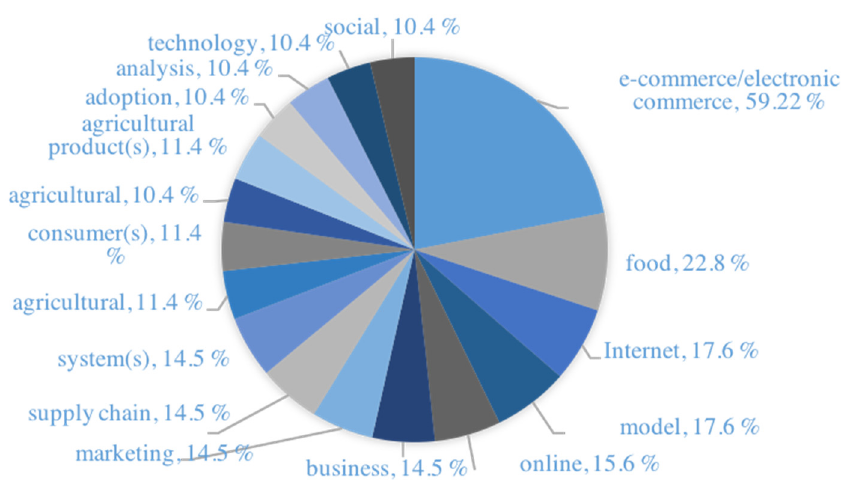
Figure 2. Overview of the most frequently used keywords.